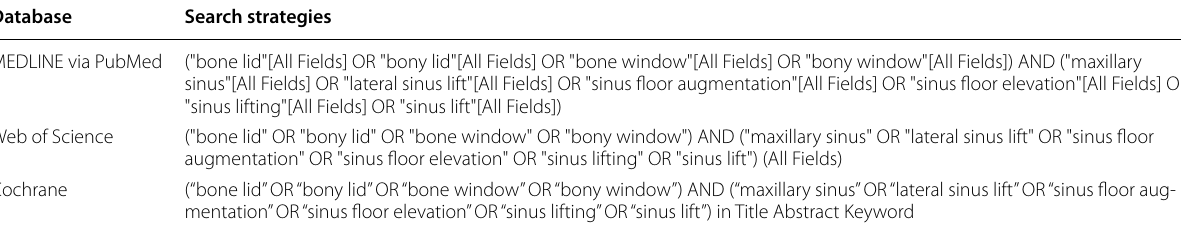
Table 1 Details of search strategies Database Search